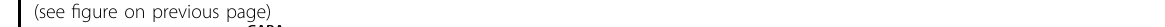
Fig. 1 Activity of dDpMe GABA neurons across different brain state transitions. a Schematic showing the fi ber photometry used to assess GCaMP6f fl uorescence of the dDpMe in GAD2-IRES-Cre mice with simultaneous polysomnographic recordings. Drawings of irregular-shaped superimposed viral expressing sites with circle-shaped micropipette tips ( n = 5). b Raw traces of GCaMP6f fl uorescence changes that were associated with different brain states. c Mean normalized fl uorescence ( z -score) during wake, NREM sleep, and REM sleep ( n = 5 mice), taking the mean of 8 sessions per mouse; one-way ANOVA between brain states: F (1.324, 5.295) = 17.12, P = 0.0065; * P < 0.05, ** P < 0.01, followed by Tukey ’ s multiple comparison test, P (REM – Wake) = 0.022 and P (REM – NREM) = 0.018. d Ca 2 + normalized signals ( z -score) associated with transitions among brain states. Top, individual transitions with color-coded fl uorescence intensity; bottom, z -score of fl uorescence changes from all transitions expressed as means (blue trace) ± SEM (shading). e Schematic showing the multichannel recording in vivo used to assess signal units by optic tetrodes with simultaneous polysomnographic recordings ( n = 35). Typical fl uorescent images representing the dDpMe labeled by ChR2-mCherry near the ChAT-labeled PPT (Green) and recording sites identi fi ed by electrolytic lesions stained by Nissl. f Example unit. Top, spike raster showing multiple trials of 470 nm laser stimulation. Bottom, raw trace showing spontaneous and laser-evoked spikes. Red, mean spontaneous fi ring rate of Type 1 neurons; yellow-green, mean spontaneous fi ring rate of Type 2 neurons; blue, laser-evoked spikes. g The fi ring rate of the neuron with the EEG spectrogram, EMG trace, and brain states (color coded). Freq, Frequency. There are two types of neurons among all identi fi ed GABAergic units in the dDpMe. Red, Type 1; yellow- green, Type 2. h The variation of identi fi ed dDpMe GABAergic neuronal fi ring rates at state transitions. To display the whole process of each phase, we picked up 30 s before and after each time point of state transitions, and then the fi ring rates averaged during REM sleep, wake, or NREM sleep were within each segments. Shading indicates ± SEM. i REM-NREM (R-N) vs REM-wakefulness (R-W) activity difference. j Mean fi ring rate of two-type dDpMe GABAergic neurons among brain states. Assessed by one-way ANOVA followed by Tukey ’ s multiple comparison test, * P < 0.05, ** P < 0.01. Type 1: n = 22, P (REM – Wake) = 2.0 × 10 − 4 , P (REM – NREM) = 9.2 × 10 − 3 , and P (Wake – NREM) = 2.6 × 10 − 3 ; Type 2: n = 13, P (REM – Wake) = 0.028 and P (Wake – NREM) = 2.6 × 10 − 3 . dDpMe dorsal part of the deep mesencephalic nucleus, PAG periaqueductal gray, PPT pedunculopontine